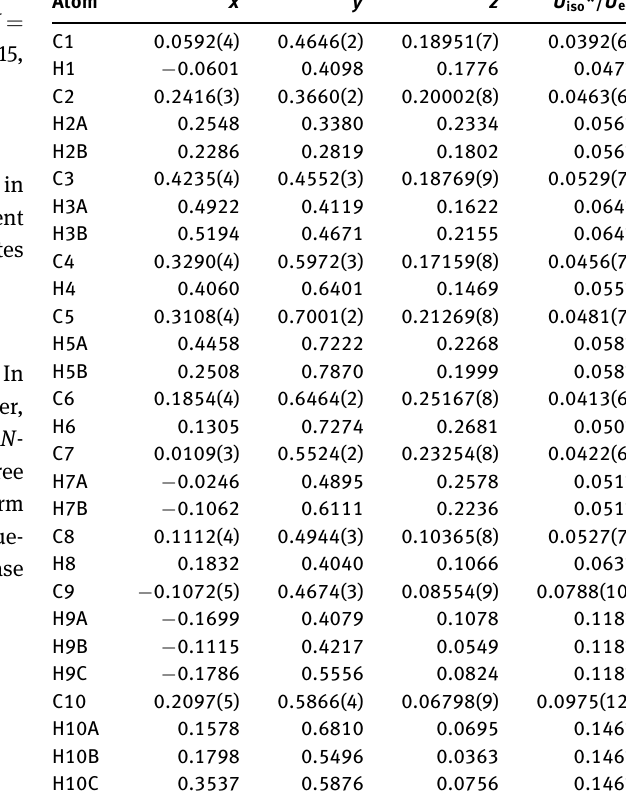
Table 2: Fractional atomic coordinates and isotropic or equivalent isotropic displacement parameters (Å 2